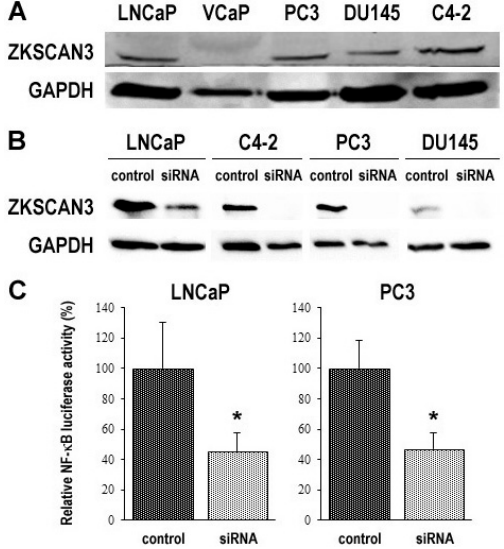
Figure 4. Silencing of ZKSCAN3 in prostate cancer cell lines. Western blotting of ZKSCAN3 (60 kDa) in 5 parental prostate cancer cell lines ( A ) or 4 prostate cancer cell lines transfected with either control-siRNA or ZKSCAN3-siRNA ( B ). GAPDH (37 kDa) served as an internal control. ( C ) NF- κ B luciferase reporter activity in 2 prostate cancer cell lines transfected with either control-siRNA or ZKSCAN3-